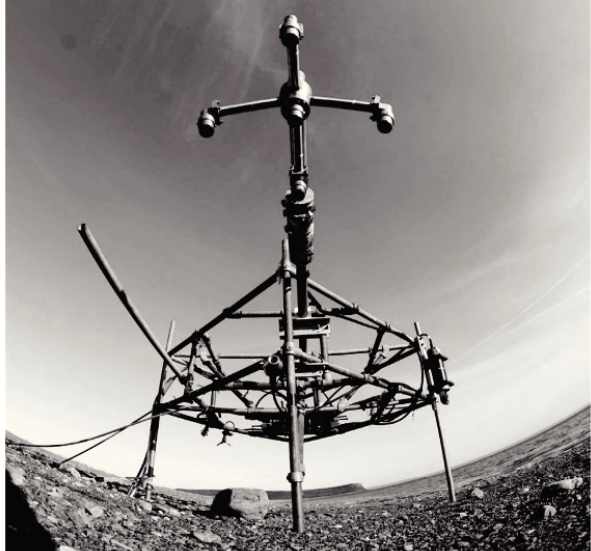
Figure 2. Fisheye view of the instrument frame, with the MFDop transducer assembly foremost. Note the wide range of bed material sizes.